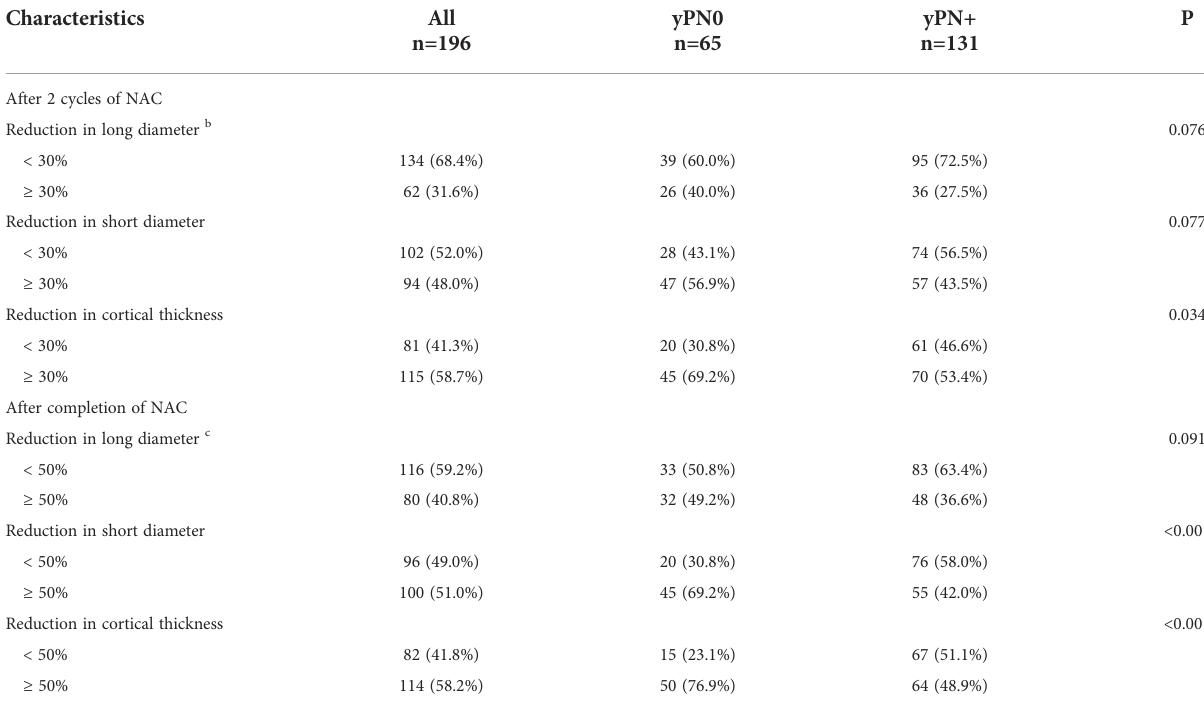
TABLE 3 Changes of ultrasound features for biopsy-con fi rmed metastatic axillary lymph node during NAC a in the training set. Characteristics